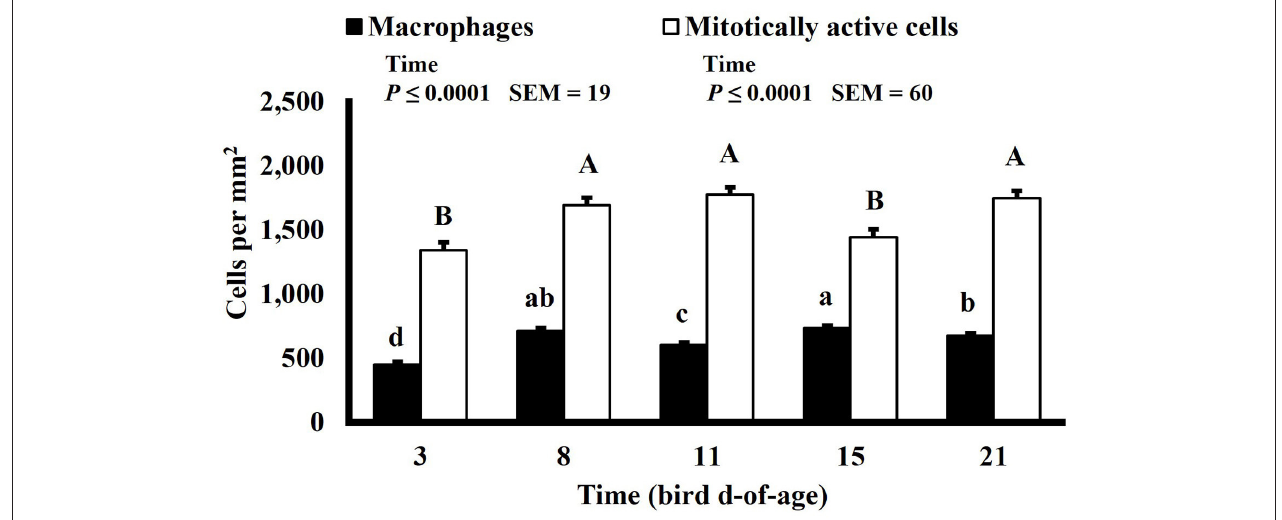
FIGURE 12 | Effect of bird age on macrophage (KUL01 + ) and mitotically active (BrdU + ) cell densities (cells per mm 2 ) in the ileum of broilers ( n = 36 per d-of-age). a − d and A − D Bars of the same color with different superscripts differ at P ≤ 0.05.